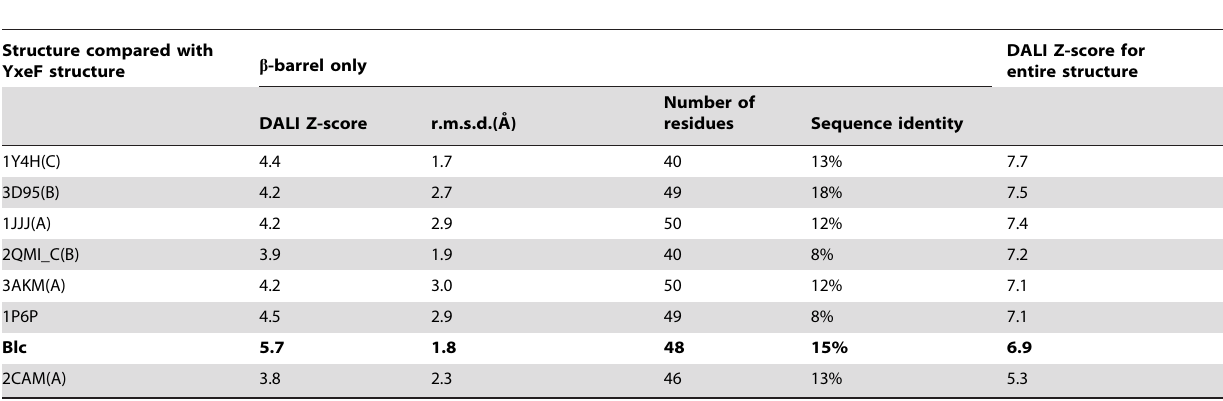
Table 2. Comparison of b -barrels occurring in selected structures a yielding top DALI Z-scores after full structure alignment with